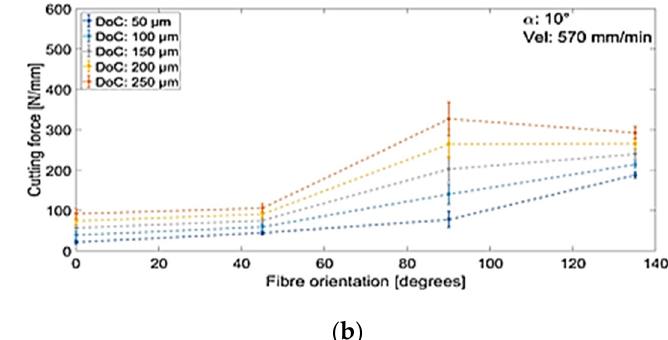
Figure 24. ( a ) Effect of orientation of fibres and depth of cut on the cutting force, and ( b ) the measured cutting force versus fibre orientations at various cutting depths when machining at a rake angle of 10 ° and cutting speed of 570 mm/min.